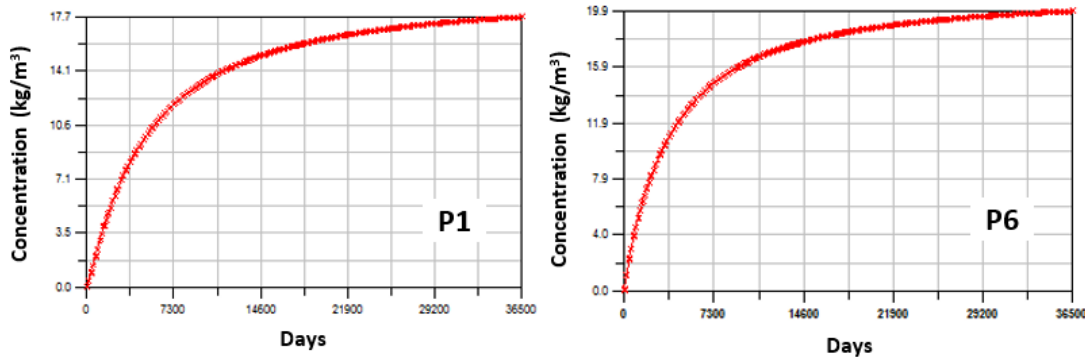
Figure 9. Simulated concentration change in P1 and P6 piezometers during the freshwater–saltwater equilibrium research phase.